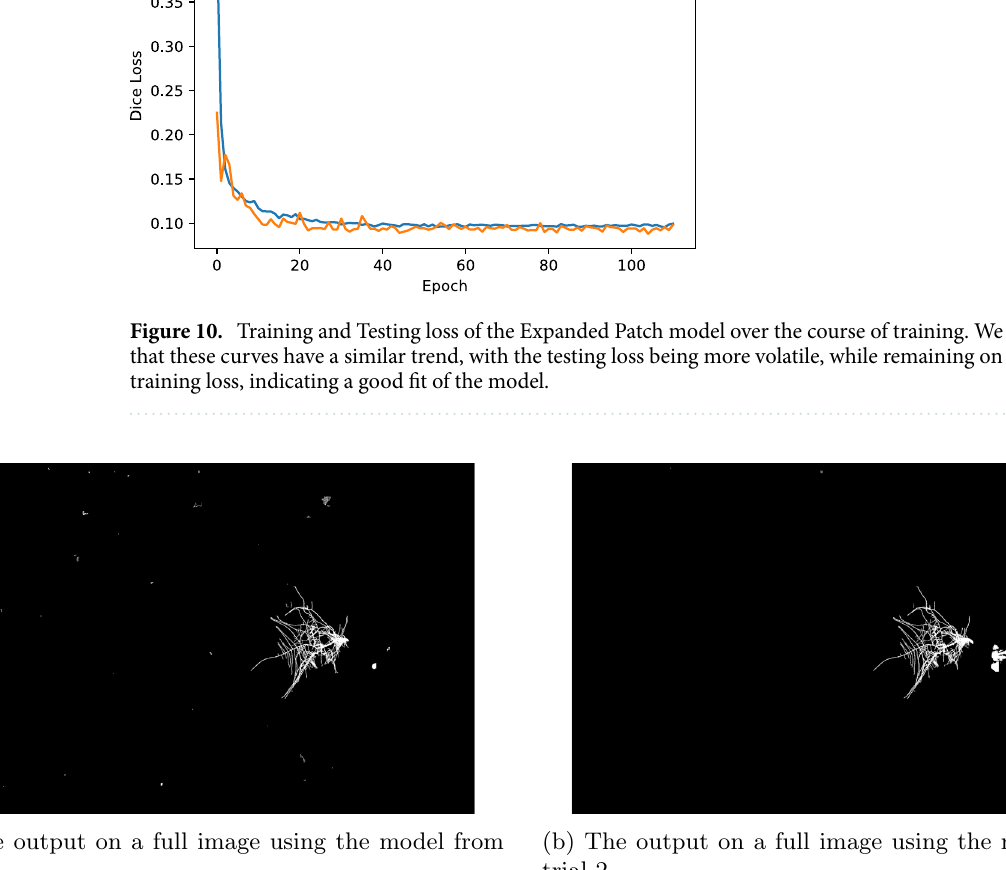
Figure 11. Full image output examples from ( a ) the model trained in trial 1 and ( b ) the model trained in trial 2. The model from trial 1 has many errors around the root system where non-root objects were incorrectly identified as root. The model in trial 2 is more robust to non-root objects in the image giving a much cleaner segmentation, though more of the above-ground plant matter is incorrectly identified as part of the root